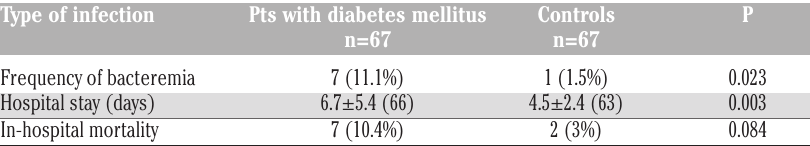
Table 4. Outcomes of the